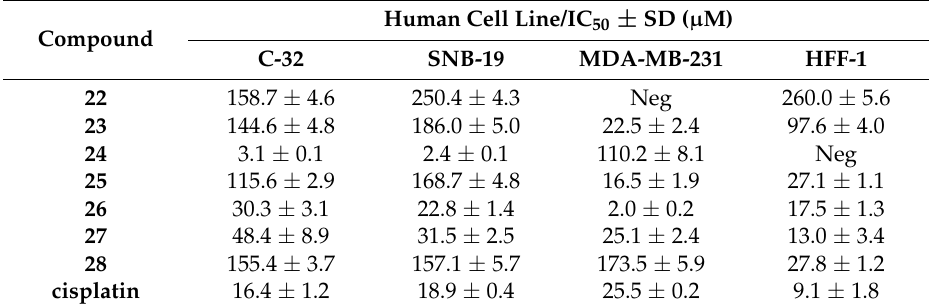
Table 2. The antiproliferative activity of Compounds 22 – 26 and cisplatin as a reference compound.